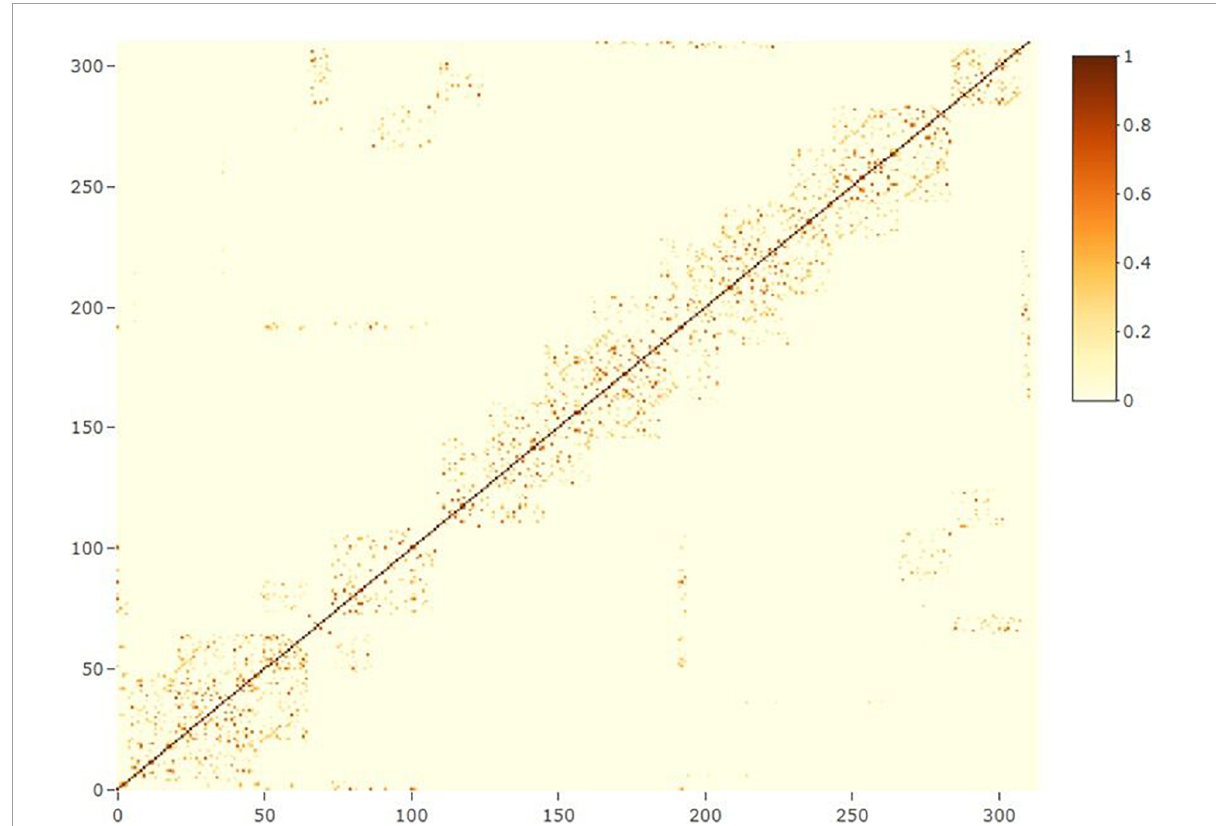
FIGURE3 Heatmap of the spatial relationship matrix for locality Dyngby in the year 2017. A total of 311 plots were observed at Dyngby 2017, and the spatial relationship between plots are represented. Higher to lower relationships are represented from yellow to light-blue colors; the dark blue represents a lack of relationship between plots (not neighboring